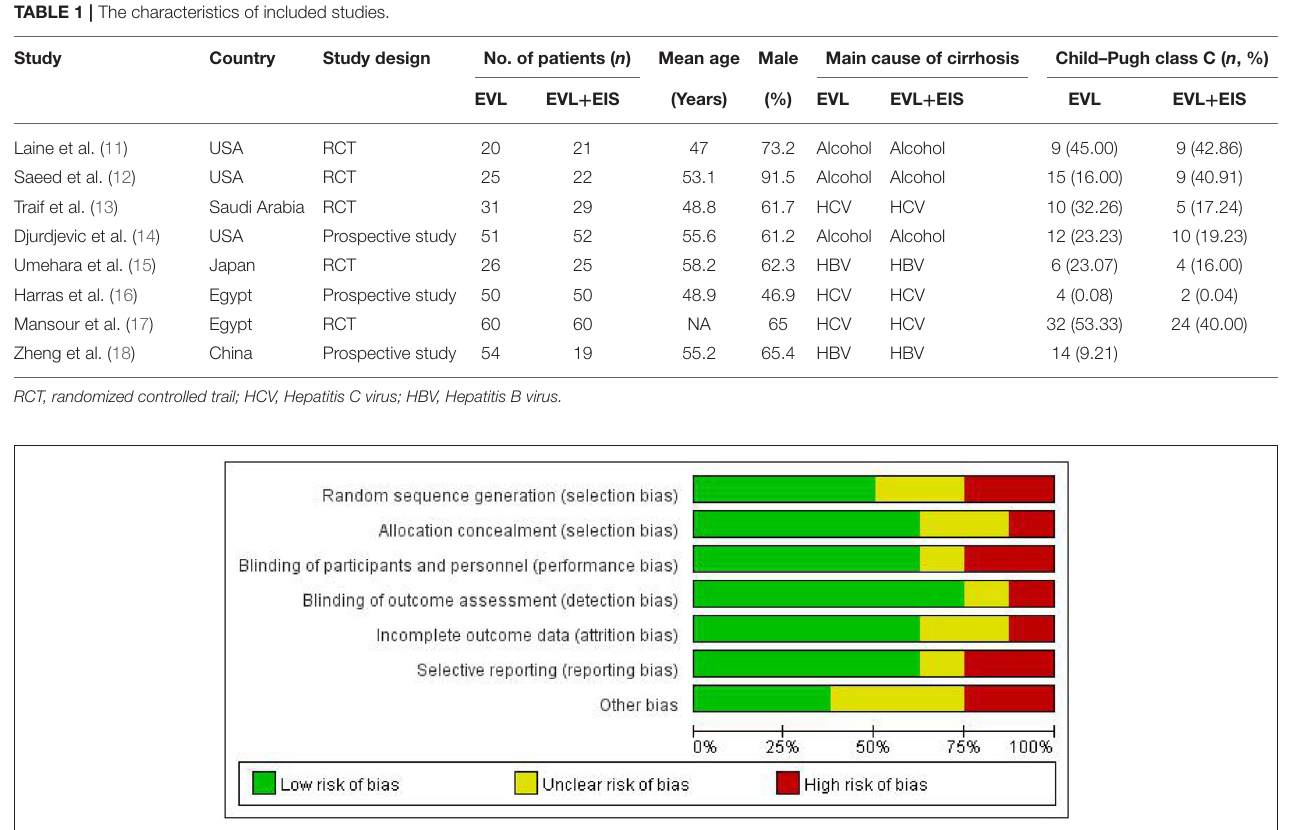
FIGURE 2 | Summary of the assessment of risk of bias.